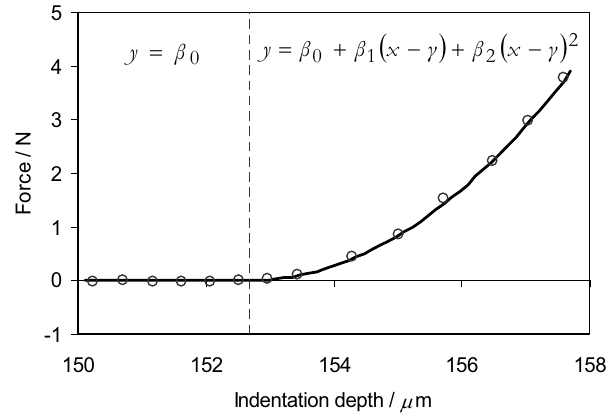
Figure 3 – Force/Depth Curve, showing applied force y plotted against indentation depth x . A segmented curve is fitted to measurement data obtained during the “Instrumented Indentation Test”. Abscissa of the zero-point ( (cid:74) ), corresponding to initial contact of the indenter with the specimen, is the unknown parameter of